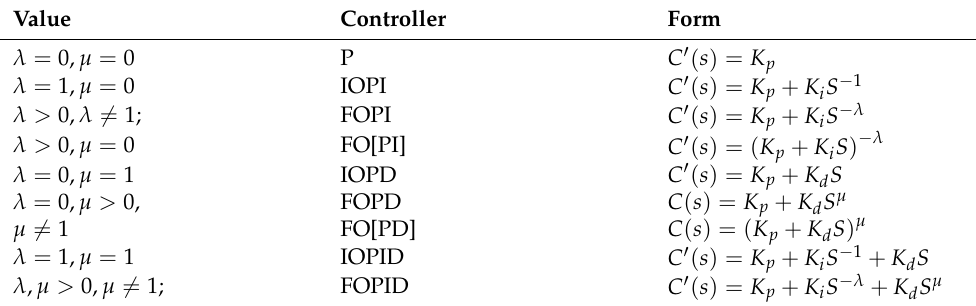
Table 3. Operating parameters of the reactor tank.